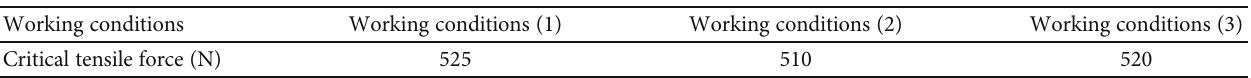
Table 8: The critical tensile force of kevlar corresponding to the working conditions of di ff erent opening diameters. Working